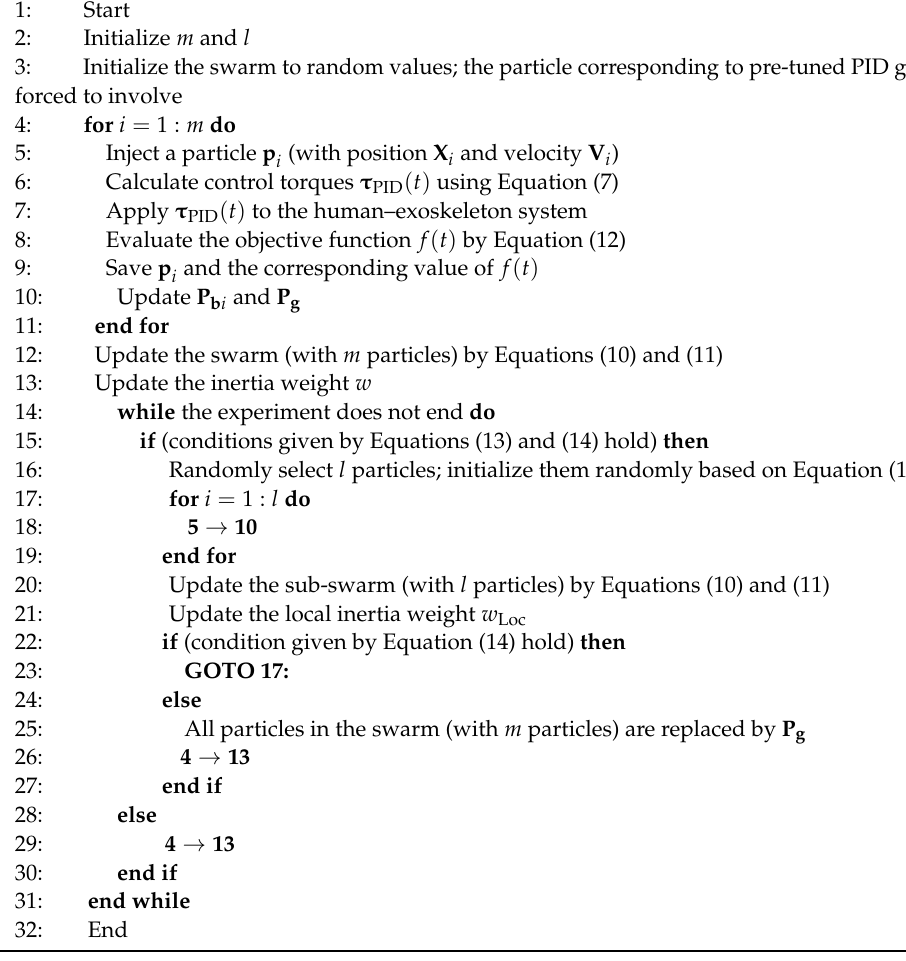
Algorithm 2 Online adaptive PID control based on improved PSO (IPSO)